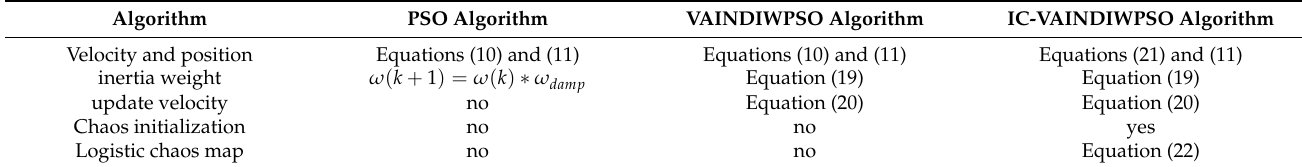
Table 1. The difference between the three algorithms.